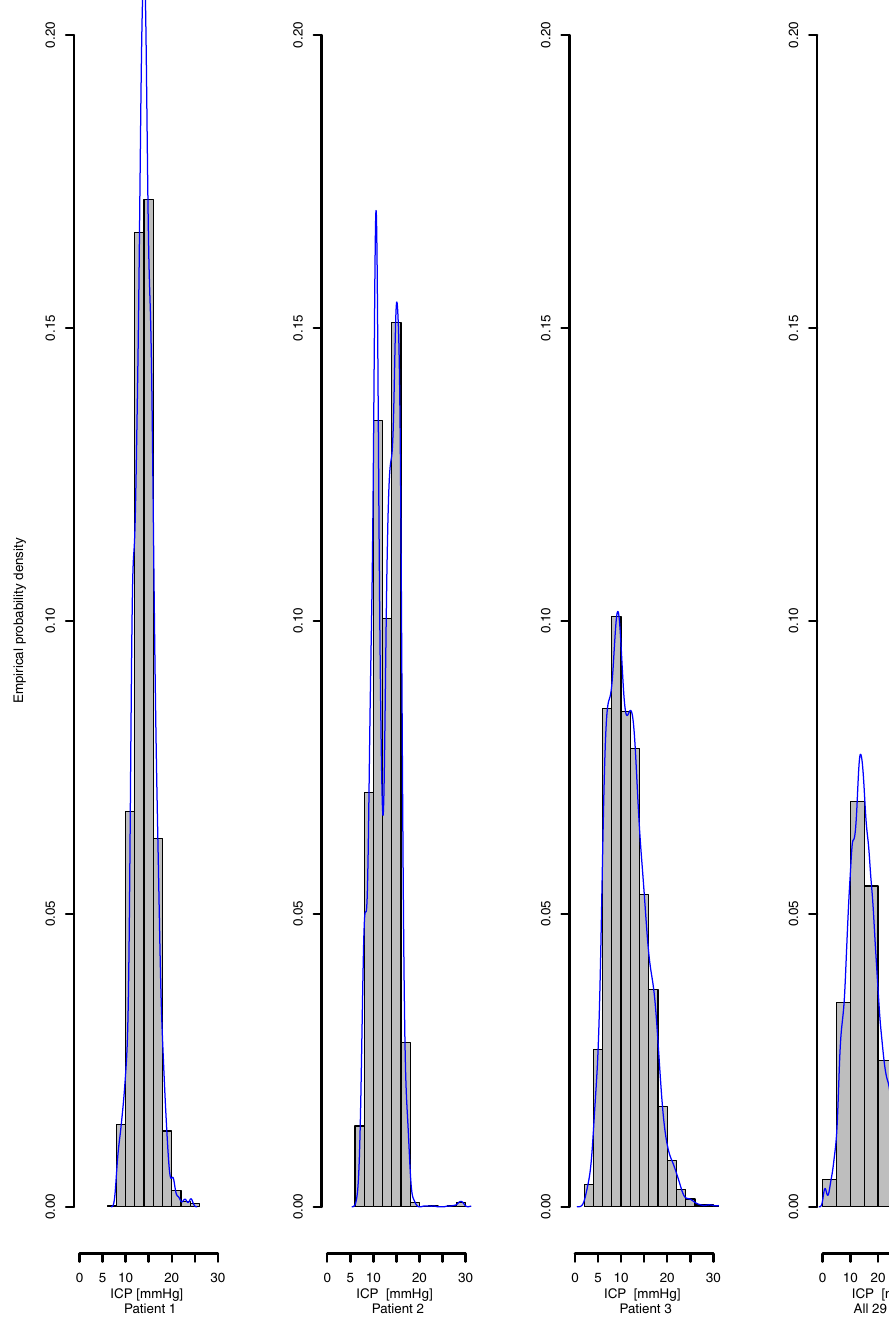
Figure 2. Probability density of ICP. The first three distributions display the probability density of the ICP measurements for three typical patients monitored and treated in the ICU. Glasgow outcome scale extended for these patients were 4, 3 and 6 respectively at 6-months clinical follow up. The rightmost distribution includes the total monitoring time for all 29